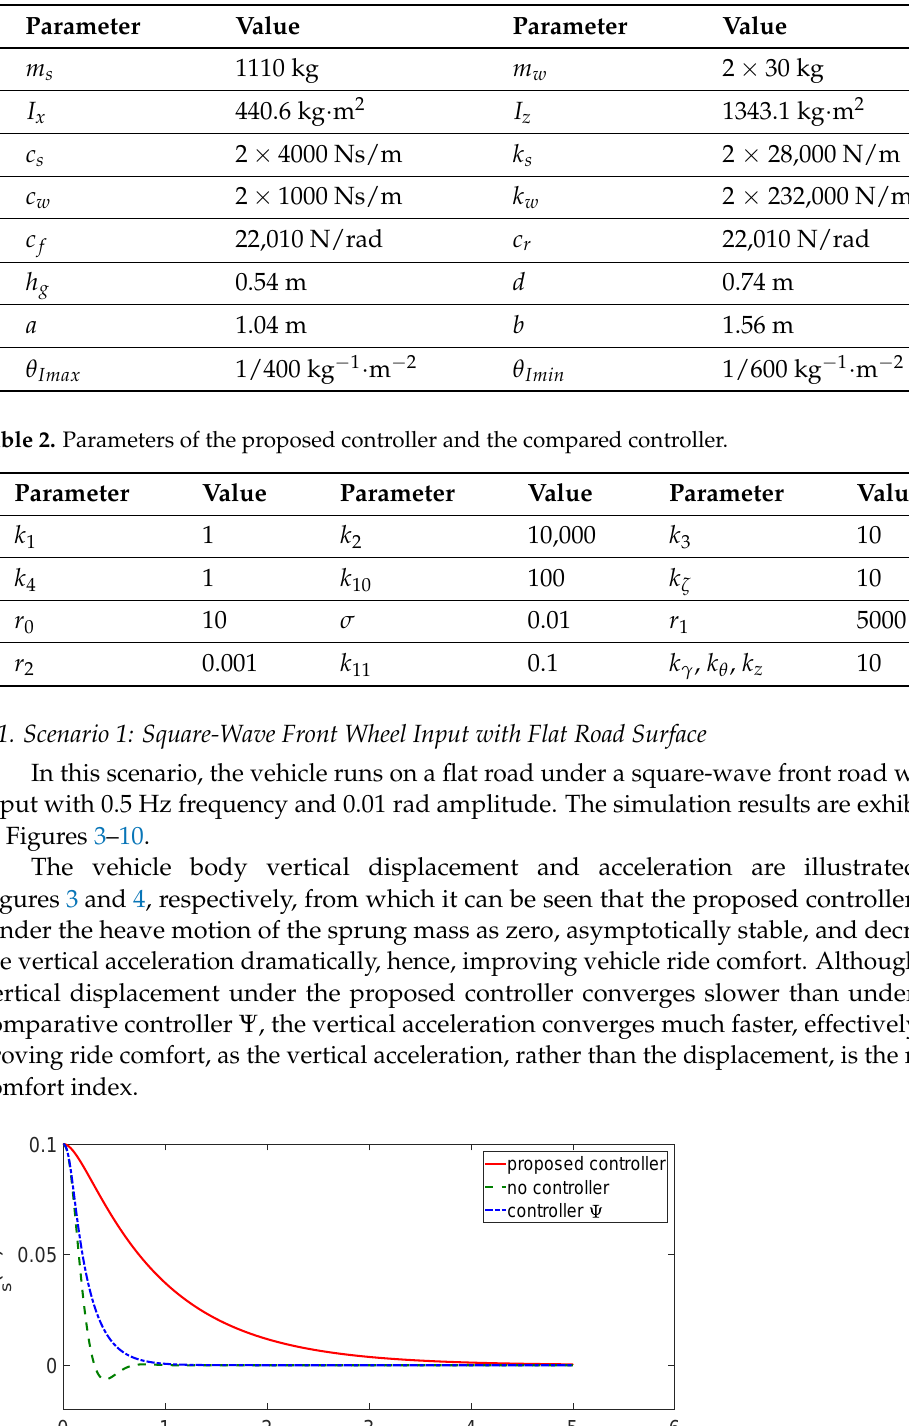
Table 1. Parameters of the vehicle model.